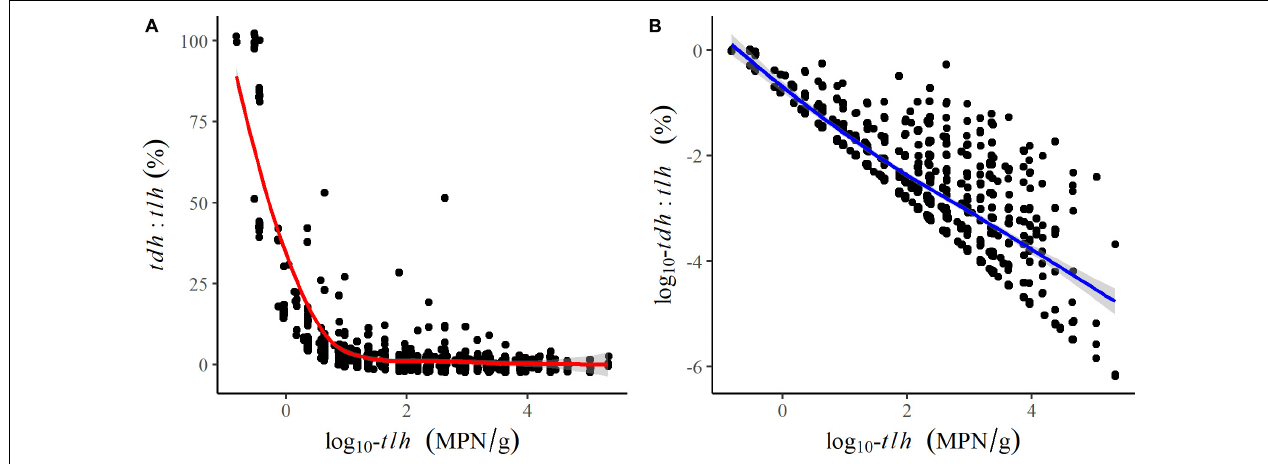
FIGURE 3 | Scatter plots and fitted LOESS lines comparing the association of log-transformed tlh to (A) the tdh : tlh ratio and (B) the log-transformed tdh : tlh ratio. TABLE 3 | Univariate and multivariate Tobit regression models of tlh , trh , and tdh and environmental/genetic covariates. tlh trh tdh Covariate Univariate Multivariate Univariate Multivariate 1 Multivariate 2 Univariate Multivariate 1 Multivariate 2 Ambient